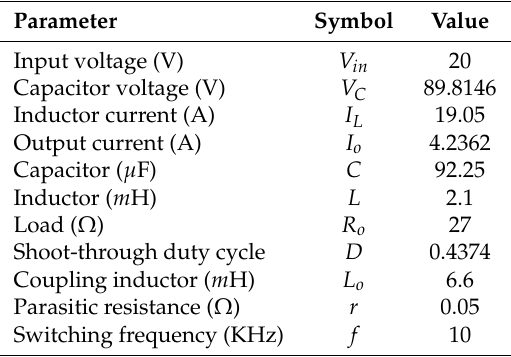
Table 1. Nominal inverter